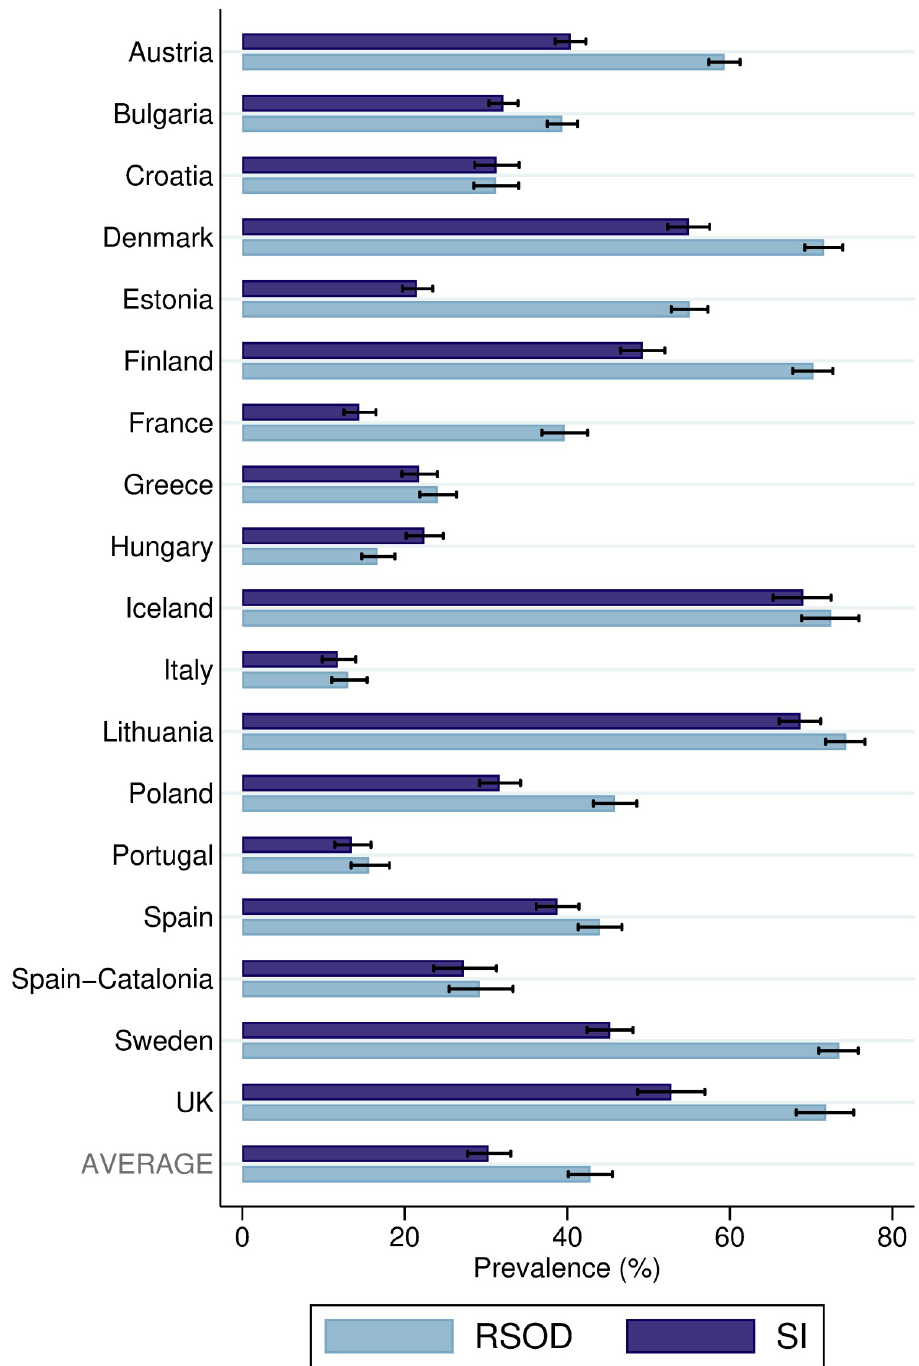
Fig 1. Prevalence and population-weighted average prevalence of RSOD and SI by location. Prevalence and population-weighted average prevalence are provided with 95% confidence intervals. At least one episode of RSOD (risky single-occasion drinking) or SI (subjective intoxication) within the past 12 months. Spain-Catalonia = Spanish Autonomous Community of Catalonia; UK = United Kingdom of Great Britain and Northern Ireland.